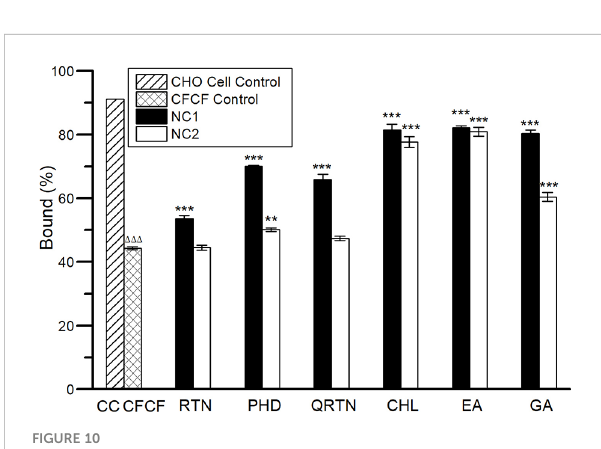
FIGURE 10 Ef fi cacy of six herbal compounds against elevated cAMP levels in CHO cell line. DDD p <0.001 compared with CHO cell control. ** p <0.01 compared with CFCF control; ***p <0.001 compared with CFCF